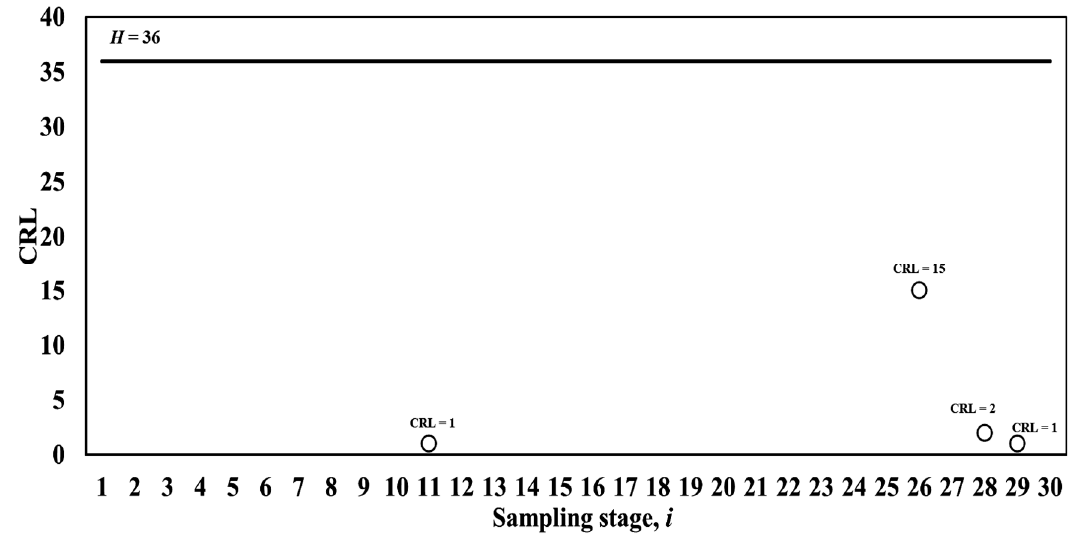
Figure 5. ( a ) DS np sub-chart of the SDS np chart for minimizing EMRL 1 . ( b ) CRL sub-chart of the SDS np chart for minimizing EMRL 1 .